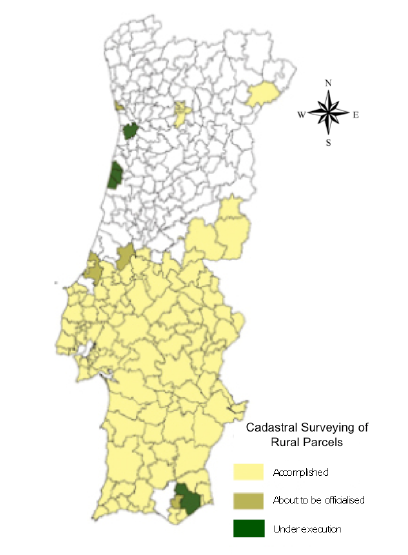
Figure 4. Portugal’s mainland districts and progress on cadastral surveying of rural real estates by 2011 (Source: